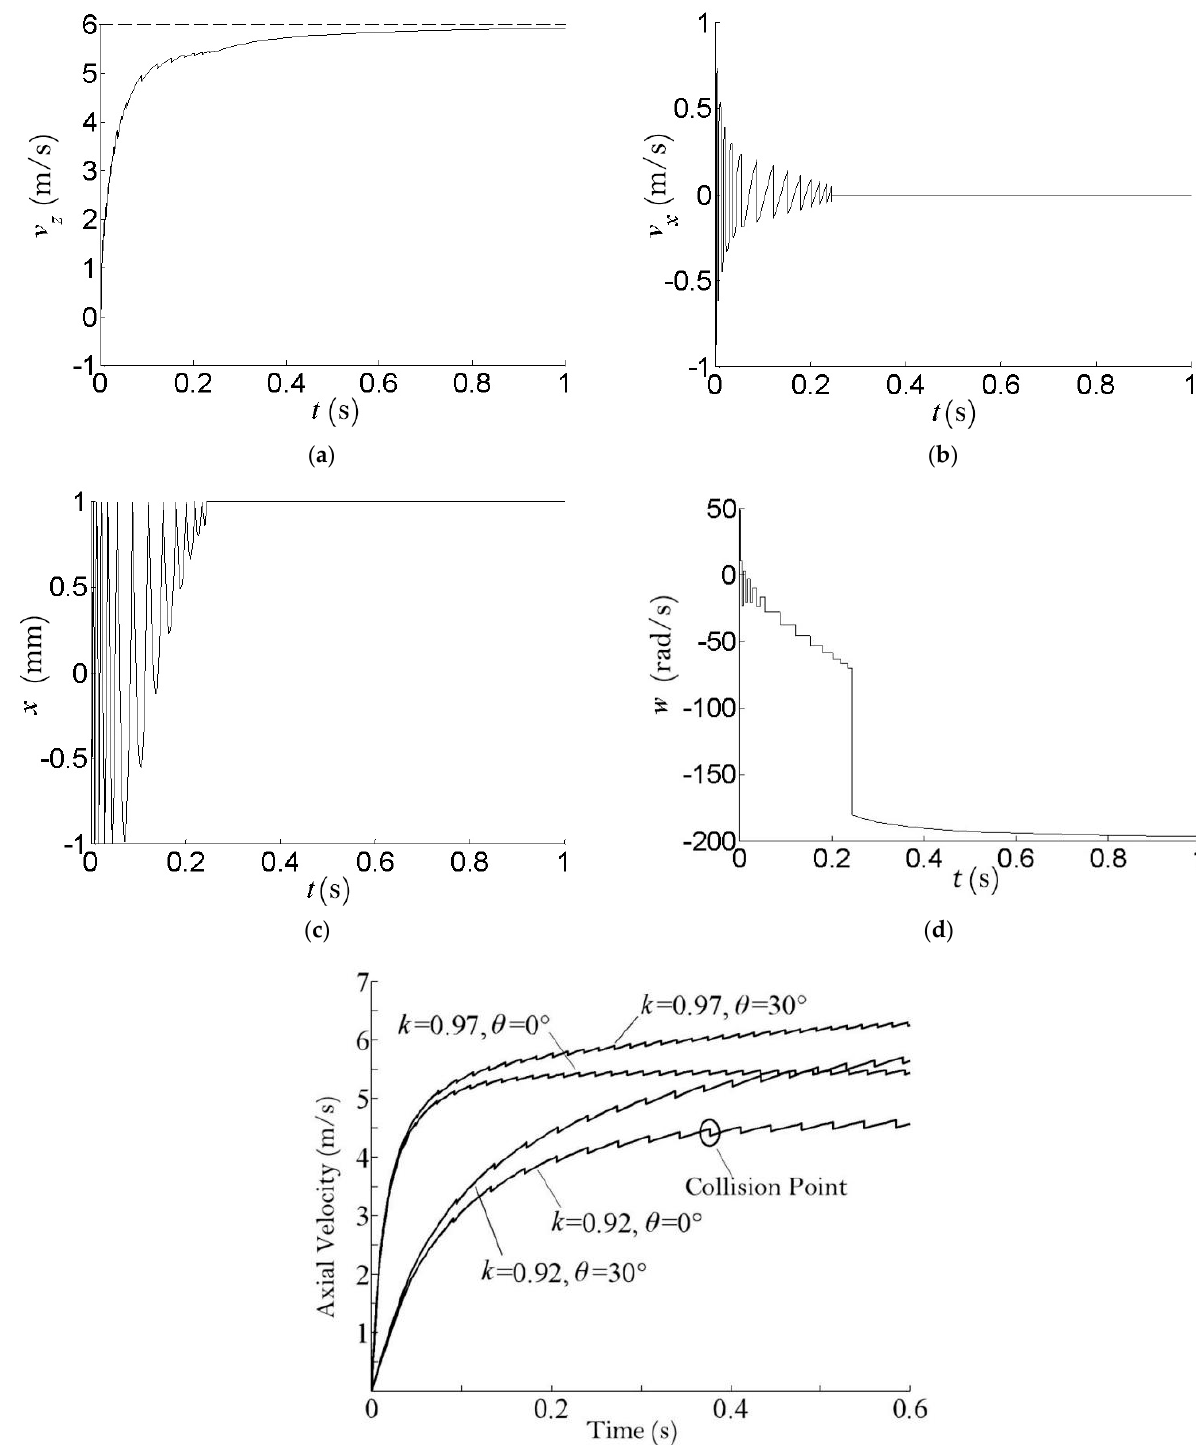
Figure 7. Acceleration − section parameters: ( a ) axial velocity, ( b ) transverse velocity, ( c ) transverse velocity, ( d ) angular velocity, ( e ) sphere/pipe − diameter ratio and pipe − inclination angle.